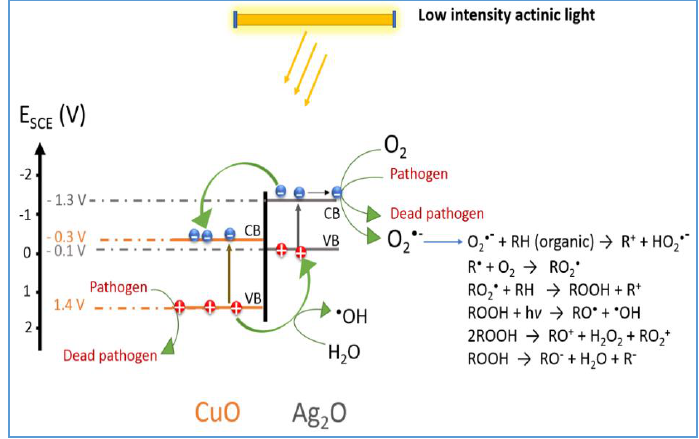
Figure 6. Interfacial charge transfer (IFCT) for Ag 2 O/CuO composites under light doses of <4 mW/cm 2 , showing the generation of ROS, leading to the inactivation of pathogens under light irradiation and the potential energy level of both semiconductor components.